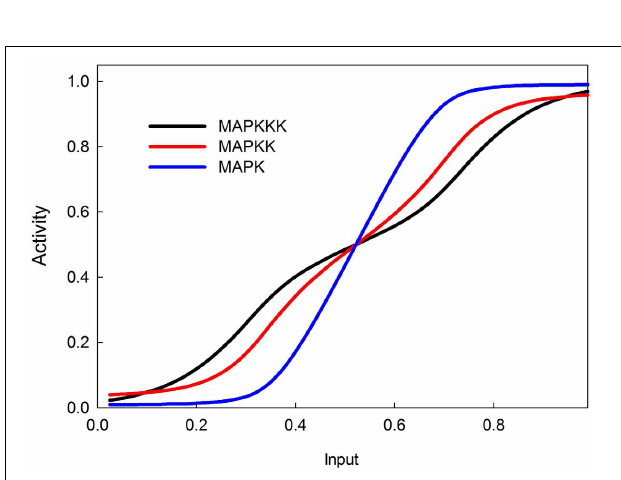
FIGURE 5 | MAPK cascade with negative feedback from MAPK to MAPKKK. The negative feedback makes the response less switchlike.